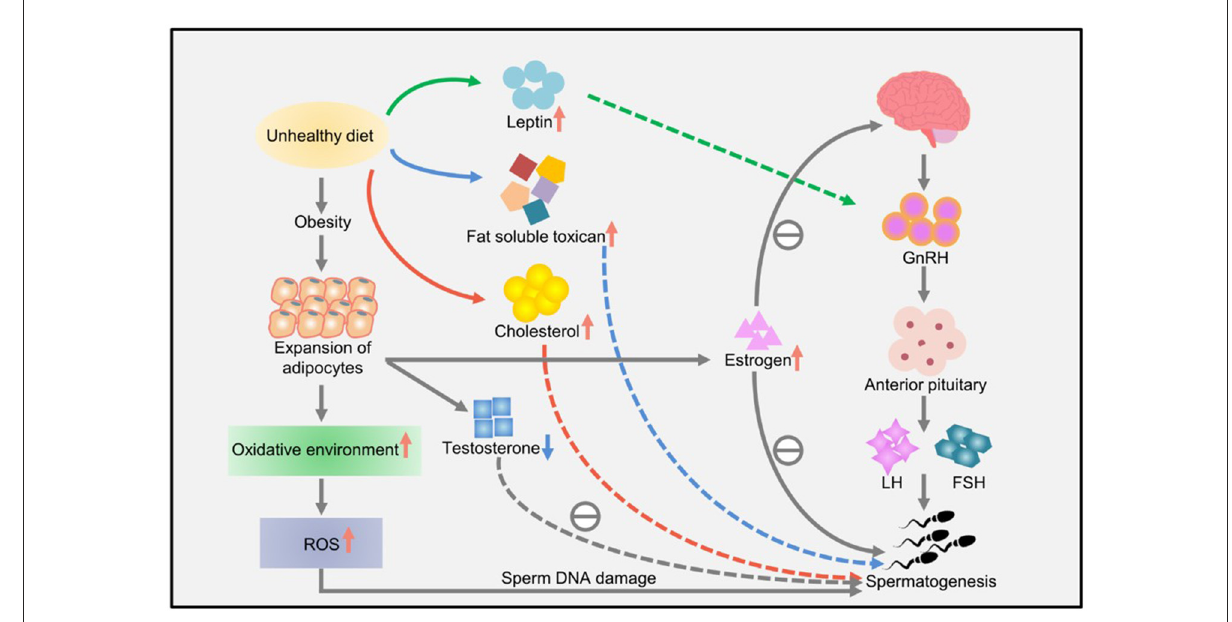
FIGURE3 The effects of diet and obesity on spermatogenesis